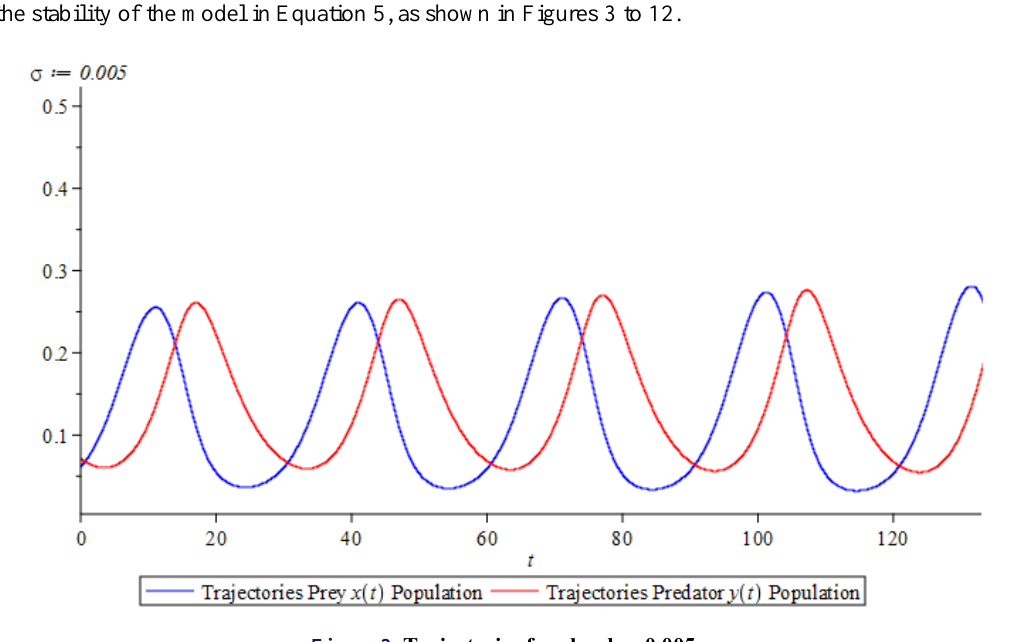
Figure 3. Trajectories fear level